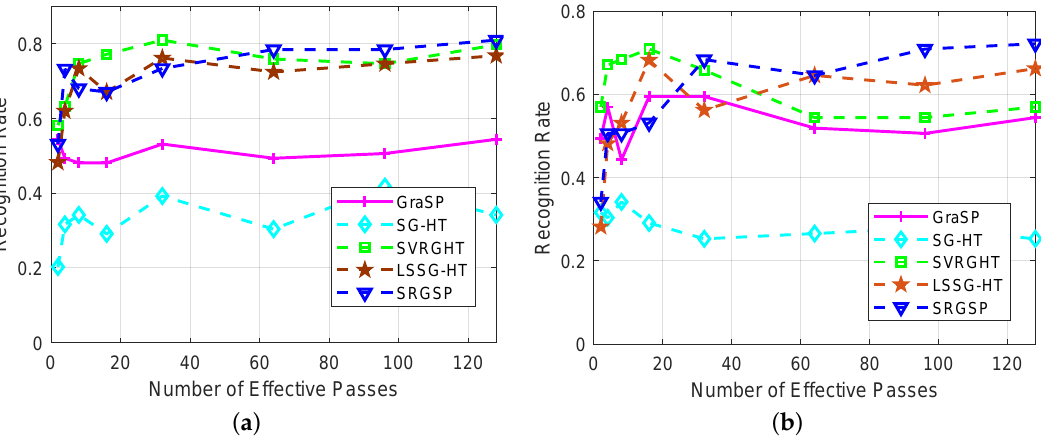
Figure 10. Comparison of recognition rates of all the algorithms on the extended Yale B and AR databases with the Gaussian noise level σ = 0.5. ( a ) The Yale B dataset; ( b ) The AR